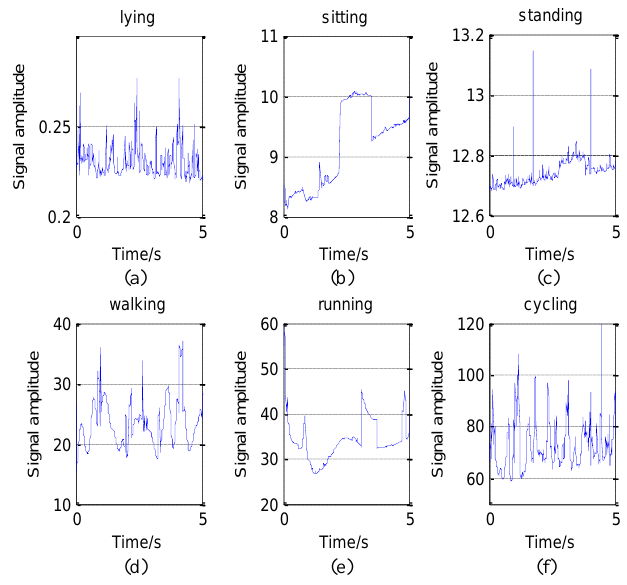
Figure 5. The instantaneous energy density level (IE) of six different activities. ( a ) The IE of lying data, the signal amplitude is very small; ( b , c ) The IE of sitting and standing, which are similar in signal amplitude; ( d – f ) The IE of walking, running, and cycling respectively, their amplitude and variation range of them are much larger. All data come from the z-axis of the accelerometer on the wrist.